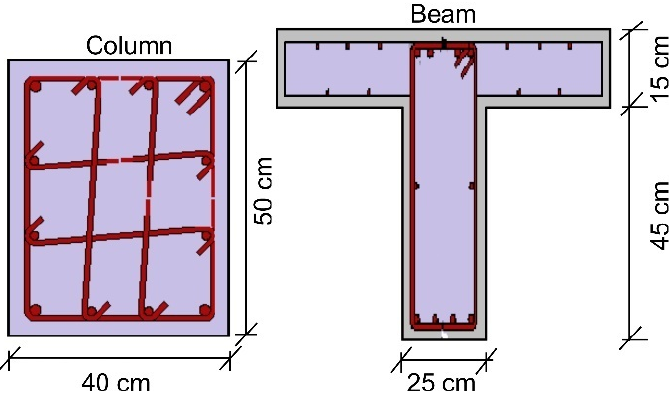
Figure 10. Column and beam cross-sections.